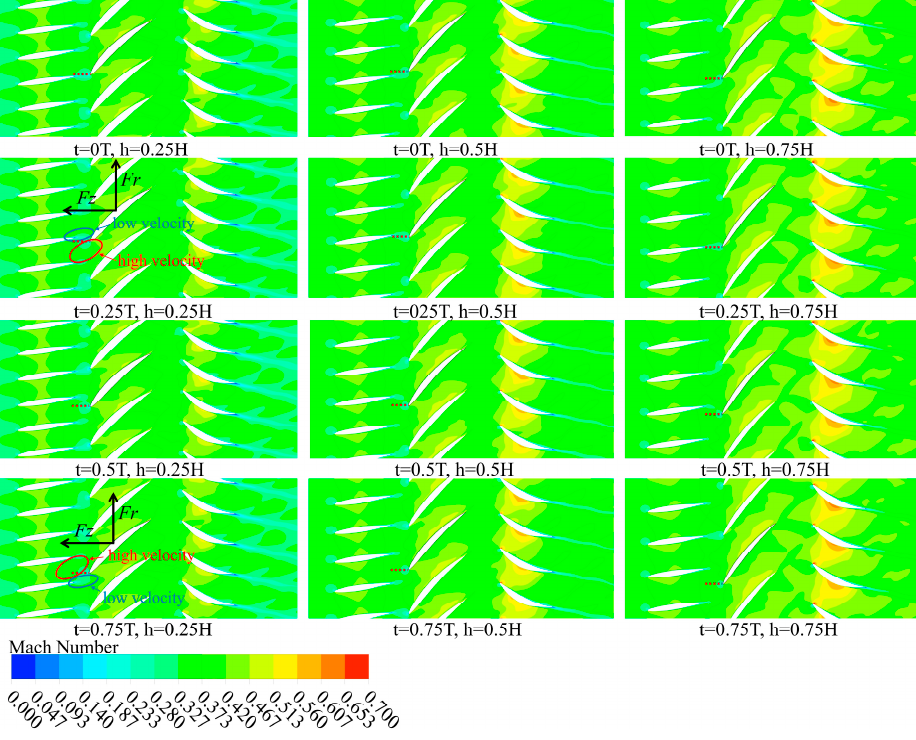
Figure 19. Mach number distribution of the 𝑎 = 0 mm model under near-blockage conditions.